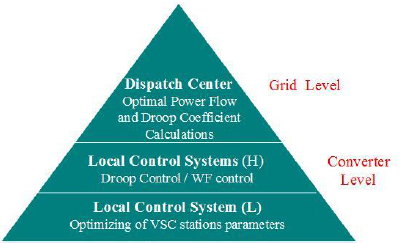
Figure 4. Control organization for CIGRE B4 test grid.